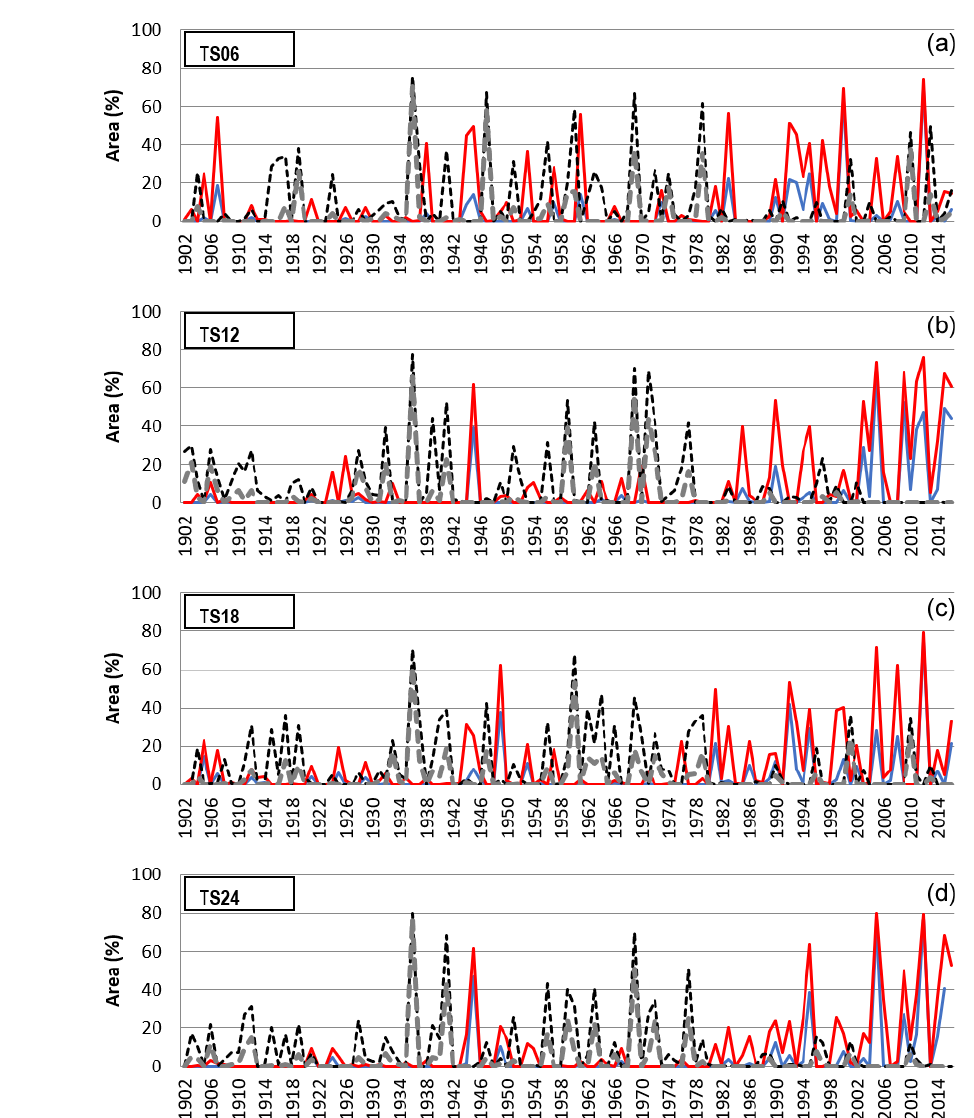
Figure 4. Similar to Fig. 3 but for area (A, in percent), for the four